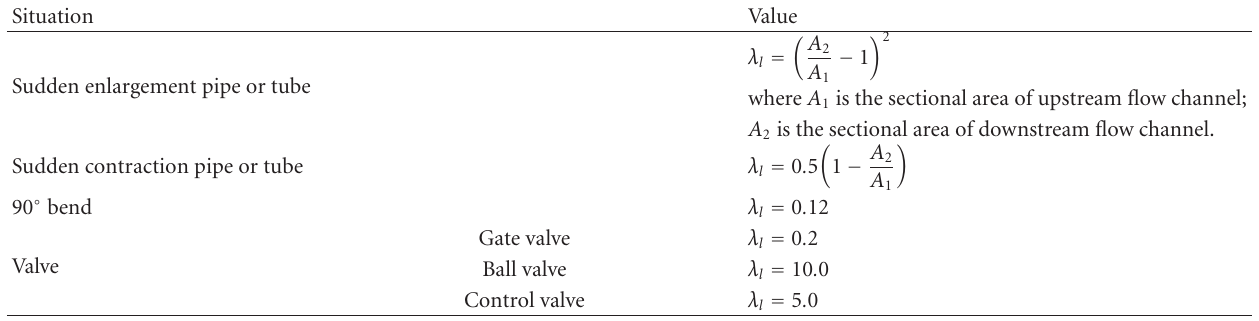
Table 6: Values of λ l in the case of steam or water.